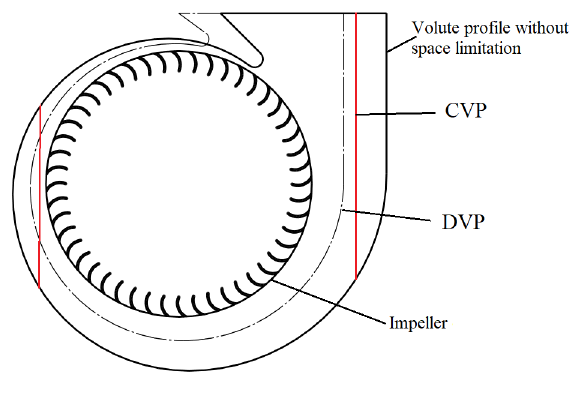
Figure 1. Volute design method under size